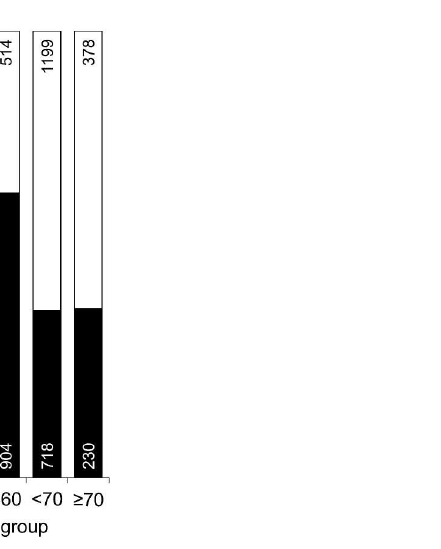
Fig 3. Frequency of participants with NRS score (cid:21) 8 points. Non-restorative sleep (NRS) score; ■ : (cid:21) 8 points; □ : < 8 points. (a) men, (b) women. Number of individualsis shown within columns.